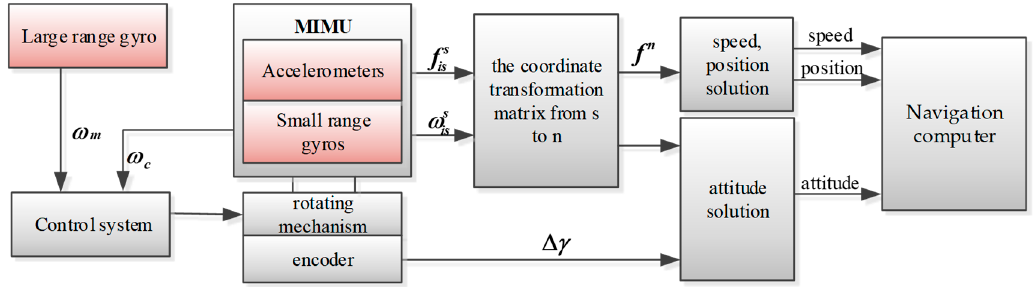
Figure 2. Working principle of the SSINS. Legend: MIMU, miniature inertial measurement unit.